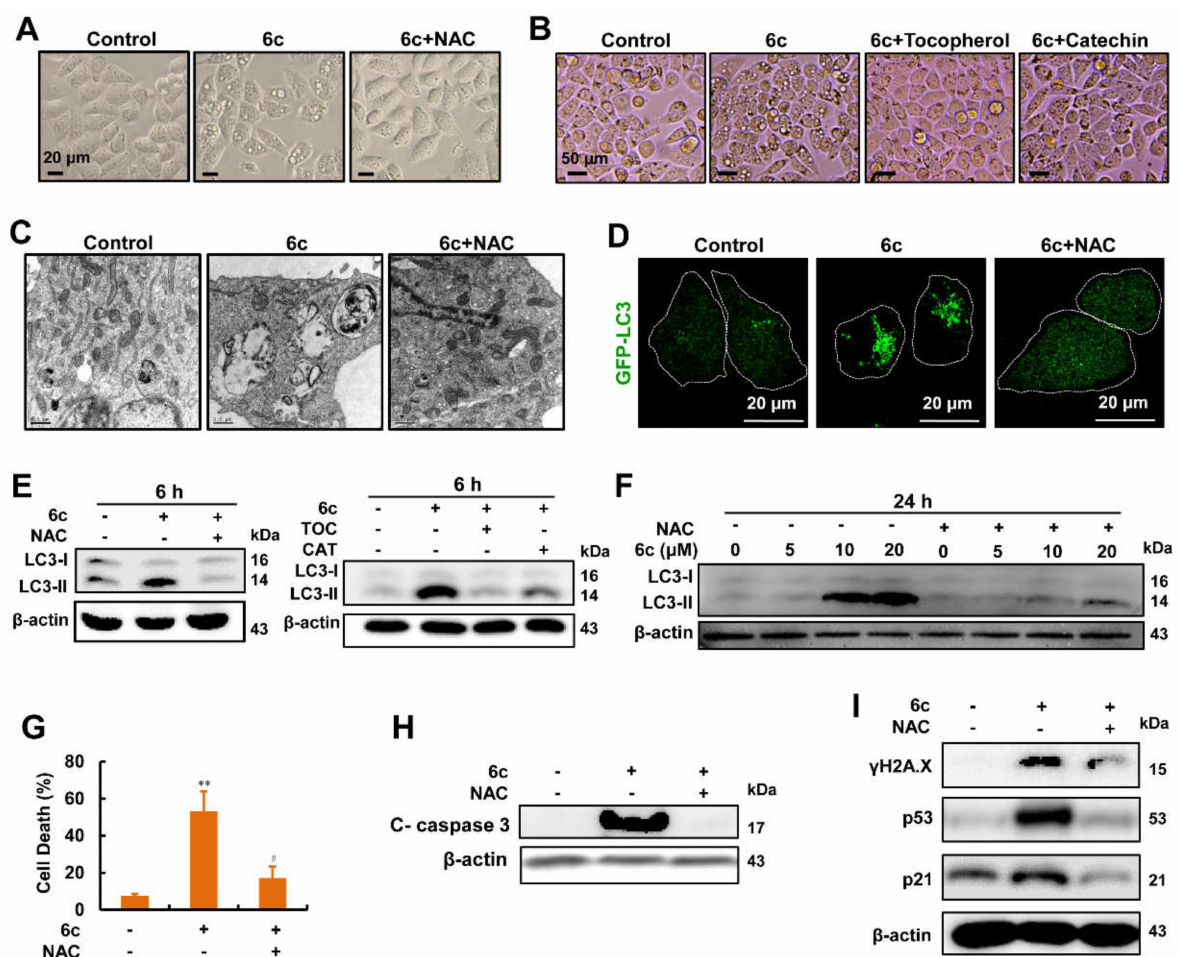
Figure 7. Compound 6c exerted its functions depending on ROS. ( A ) NAC abolished the cytoplasmic vacuolations induced by 6c in HepG2 cells. Cells were pre-treated with NAC (10 mM) for 1 h followed by 6c (20 µ M) treatment for 6 h. ( B ) α -tocopherol (TOC) and catechin (CAT) abolished the cytoplasmic vacuolations induced by 6c in HepG2 cells. Cells were pre-treated with TOC and CAT for 1 h followed by 6c (20 µ M) treatment for another 6 h. ( C ) TEM images showed that NAC (10 mM) reduced the formation of vacuolations and autophagosome induced by 6c (20 µ M). ( D ) NAC weakened 6c-induced GFP-LC3 puncta in HepG2 cells. Transfected HepG2 cells were pre-treated with NAC (10 mM) for 1 h followed by 6c (20 µ M) treatment, and images of GFP-LC3 puncta were captured using confocal microscopy. ( E ) NAC, TOC, and CAT decreased the increased expression of LC3-II in HepG2 cells treated with 6c (20 µ M) for 6 h. ( F ) NAC reversed the increased expression of LC3-II in HepG2 cells treated with 6c for 24 h. ( G , H ) 6c-induced cell death was weakened by NAC pre-treatment. Cells were pre-treated with NAC (10 mM) for 1 h followed by 6c (20 µ M) treatment for another 24 h, and cell death was determined by staining Annexin V/PI using flow cytometry ( n = 3). The expression of cleaved caspase 3 was detected using Western blot. ( I ) NAC diminished the increased expression of γ H2A.X, p53, and p21 induced by 6c. After pre-treatment with NAC (10 mM) for 1 h, cells were further treated with 6c (20 µ M) for 24 h. ** p < 0.01 vs. control; # p < 0.05 vs. 6c treatment